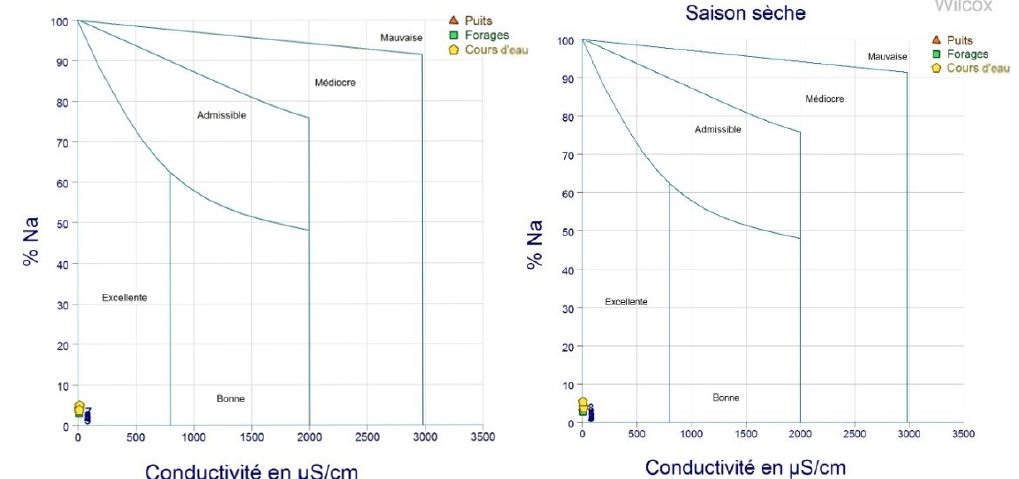
Figure 7. Diagramme de Wilcox en saison des pluies et